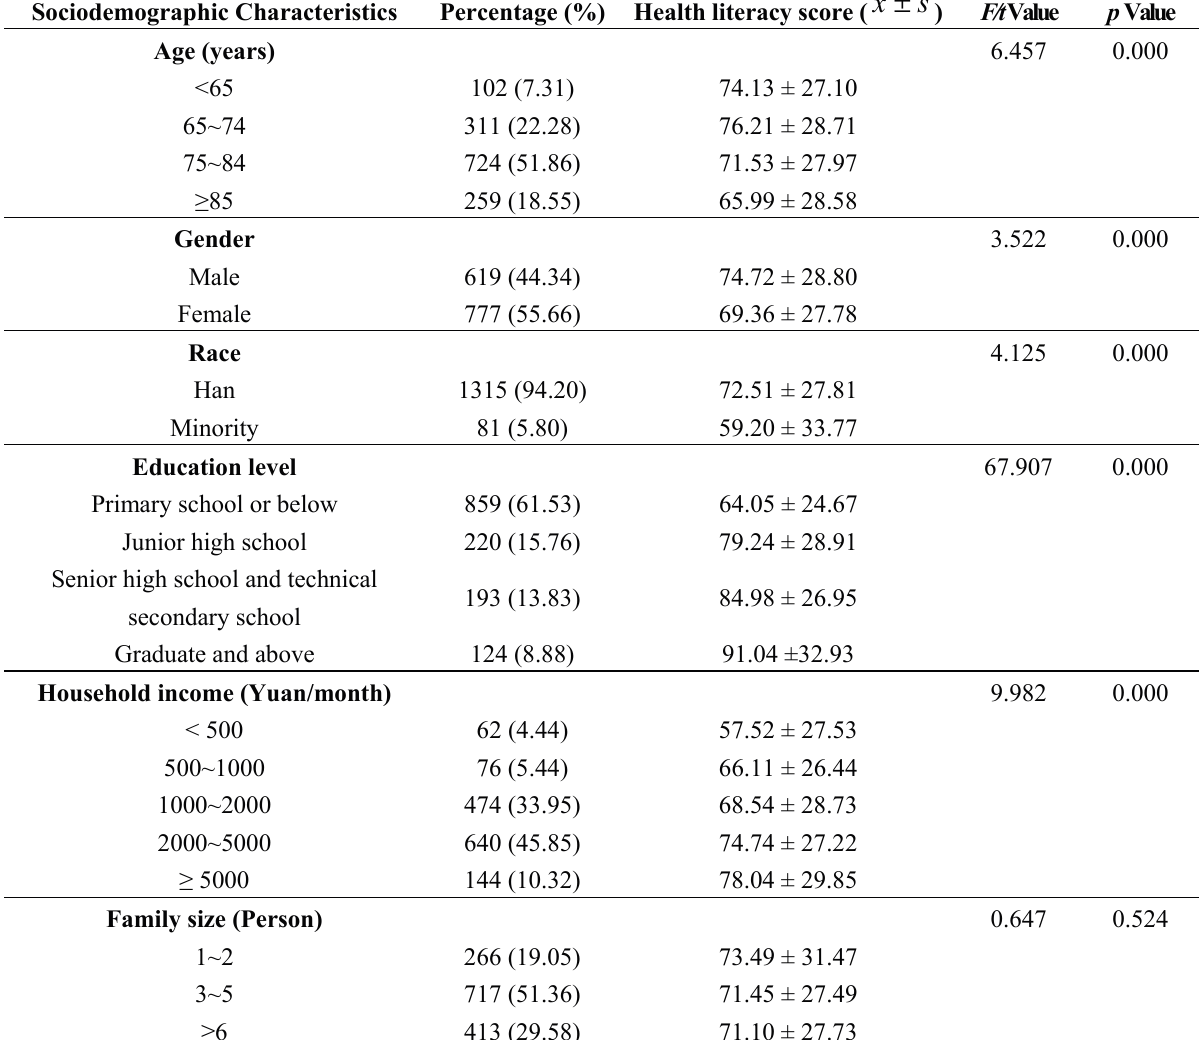
Table 1. Correlation between health literacy levels and sociodemographic characteristics in 1396 of older